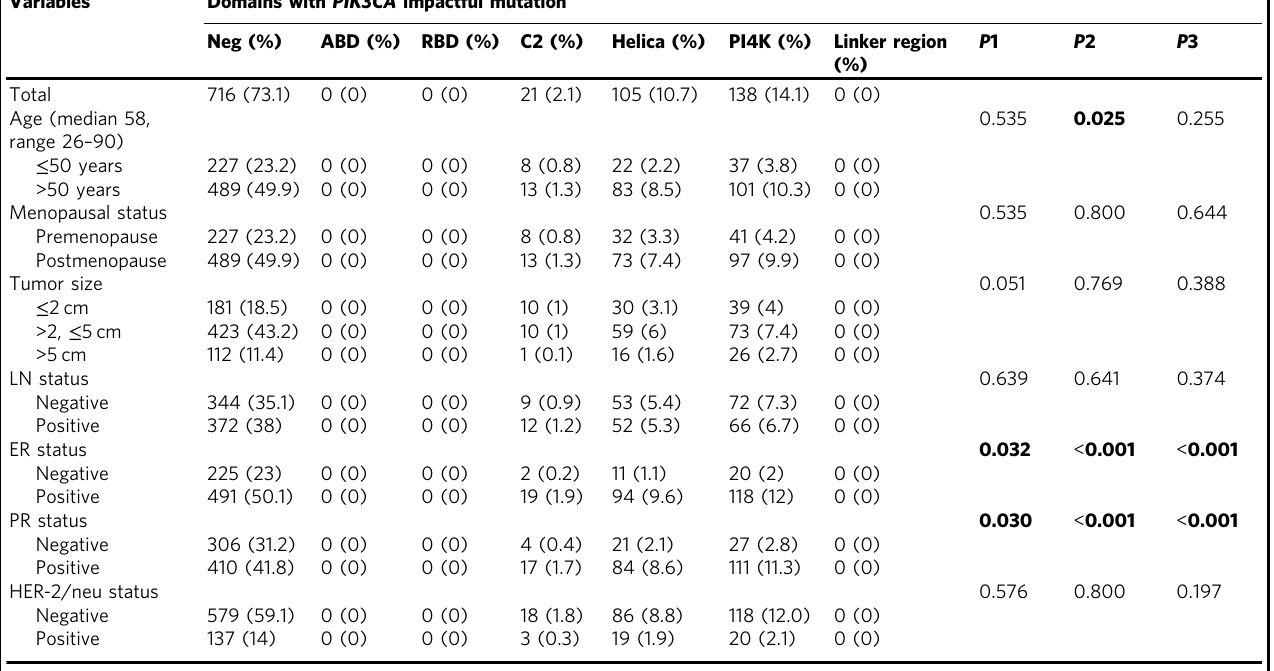
Table 2 Clinicopathological variables and the domains with PIK3CA impactful mutation in TCGA database Variables Domains with PIK3CA impactful